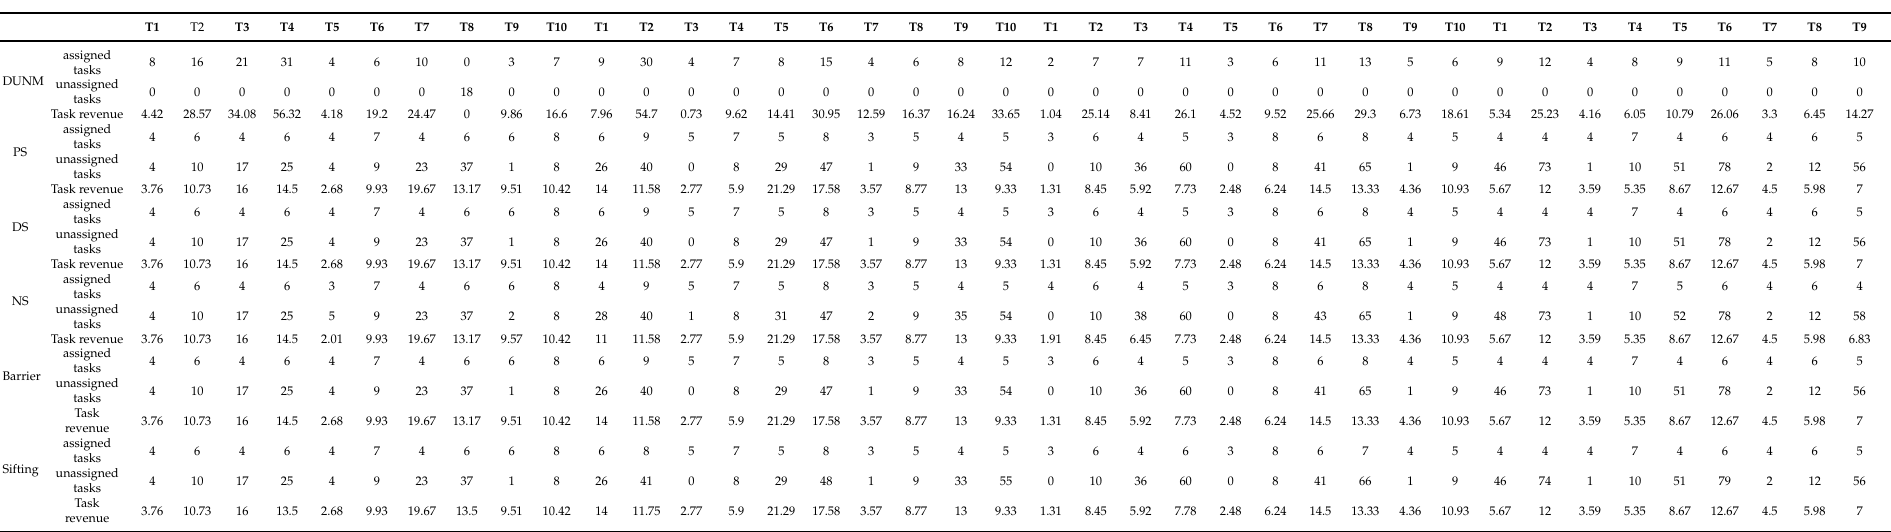
Table 4. Comparison results of DUNM and the other five algorithms in the task revenue of completing scheduling